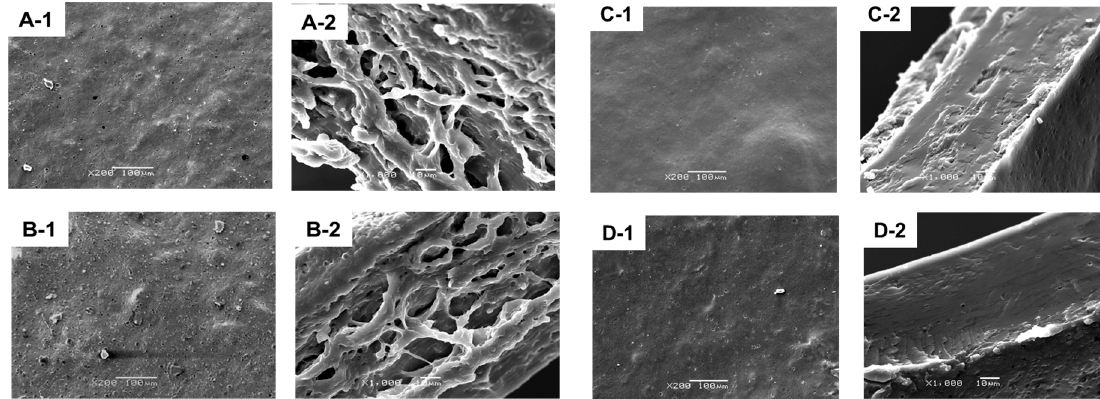
Figure 3. Microstructure of chickpea flour films. ( A ) 3% glycerol, pH 7; ( B ) 3% glycerol, pH 10; ( C ) 1% glycerol, pH 7; ( D ) 1% glycerol, pH 10. 1 : surface; 2 : cross section.